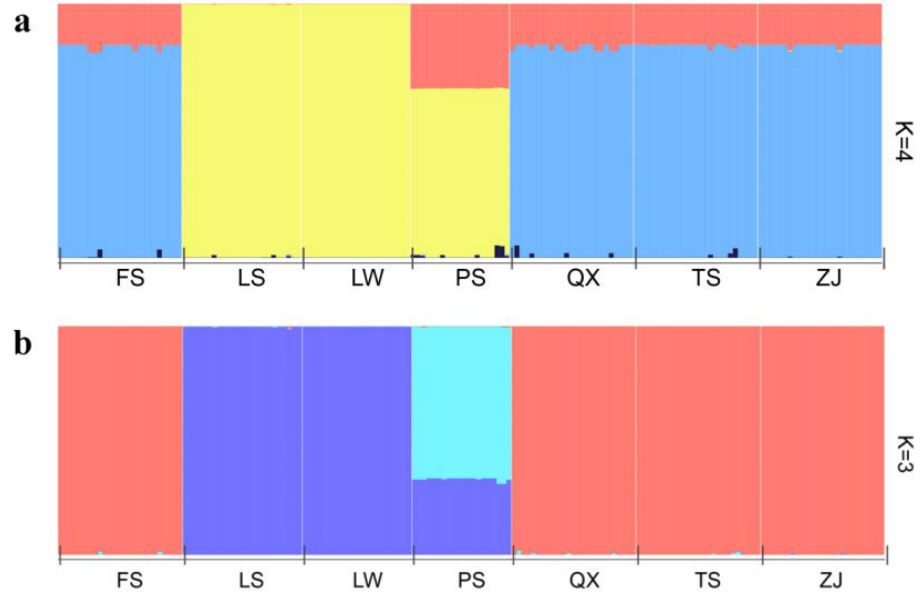
Figure 3. ( a ). STRUCTURE cluster analysis of seven populations of S. bungii (K = 4). ( b ). STRUCTURE cluster analysis of seven populations of S. bungii (K = 3).